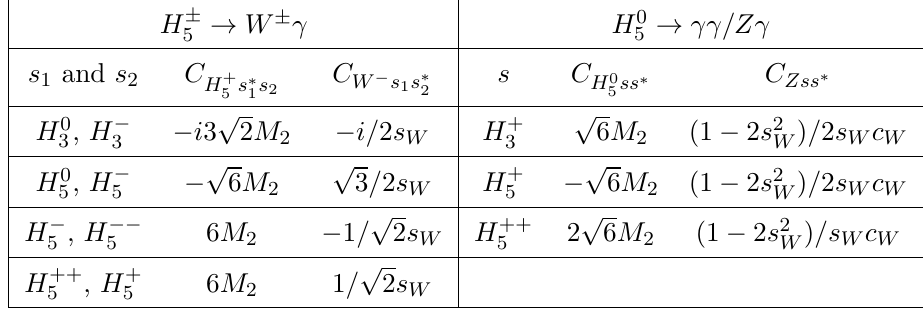
Table 4 . The scalars that contribute to the one-loop H (cid:6) the corresponding couplings in the limit s H